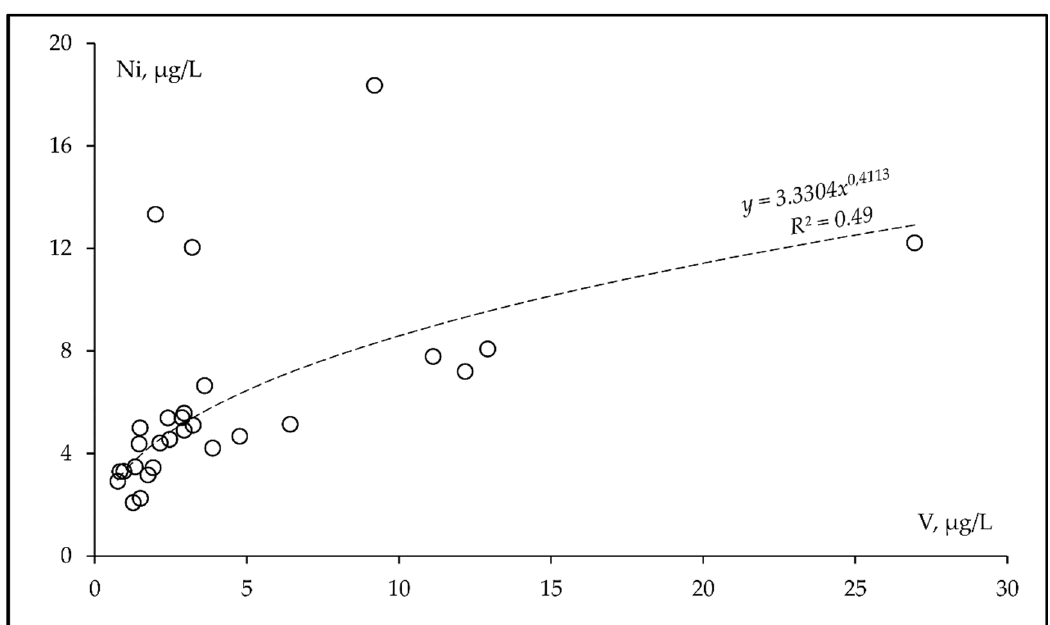
Figure 2. Correlation between Ni concentration and V content in the studied lakes.